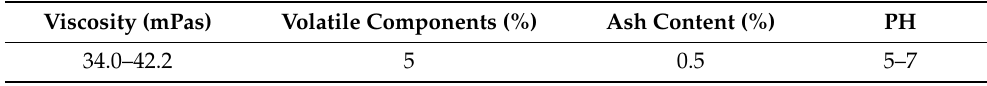
Table 2. Basic properties of PVA for